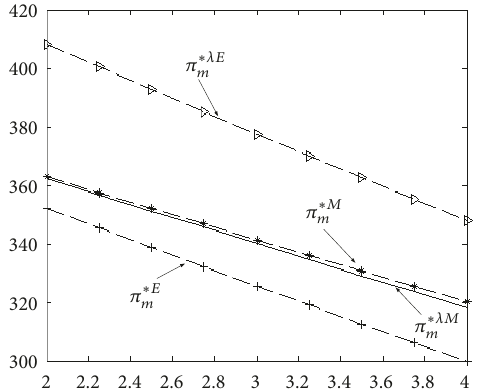
Figure 3: Change rule of service level as 𝜌 changes.